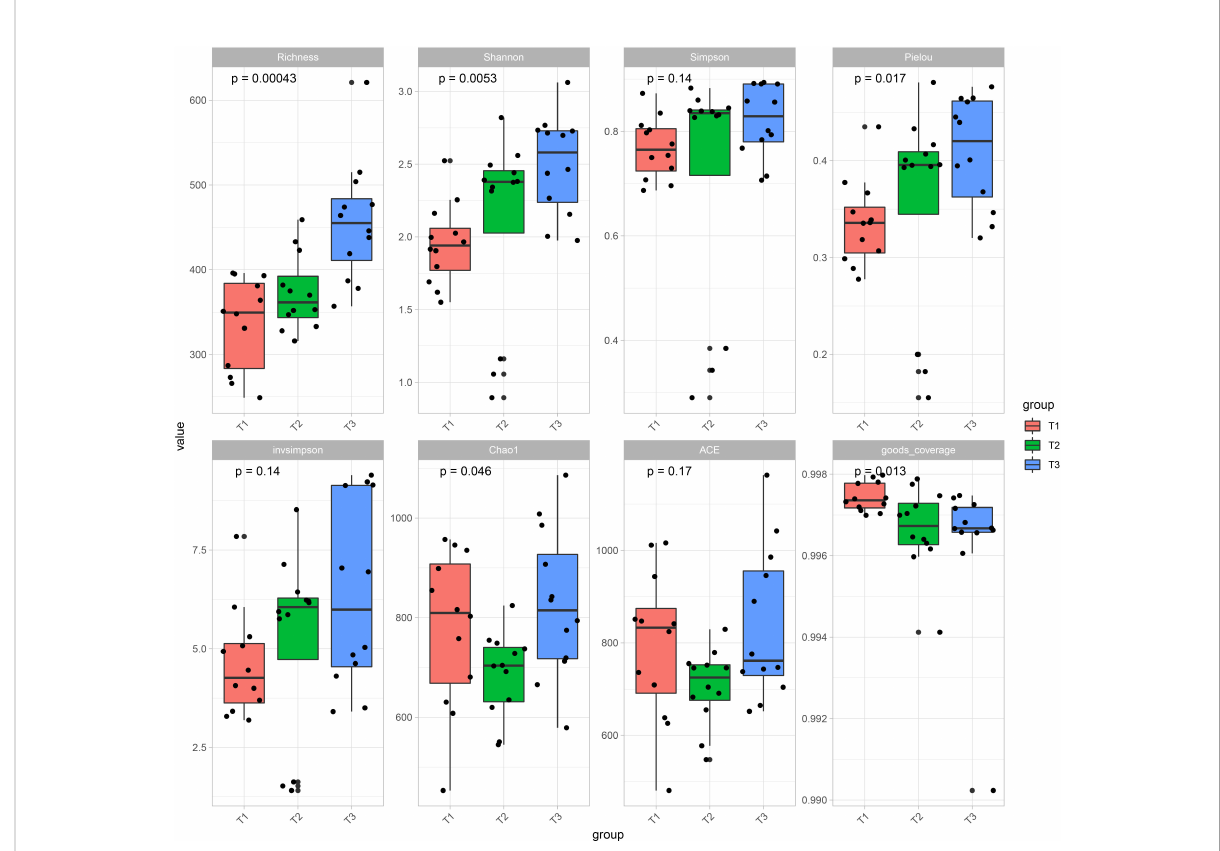
FIGURE 2 Alpha diversity indexes including Richness, Shannon, Simpson, Pielou, invsimpson, Chao1, ACE, and goods coverage of tobacco phyllospheric bacterial communities in each time series group (T1, T2 and